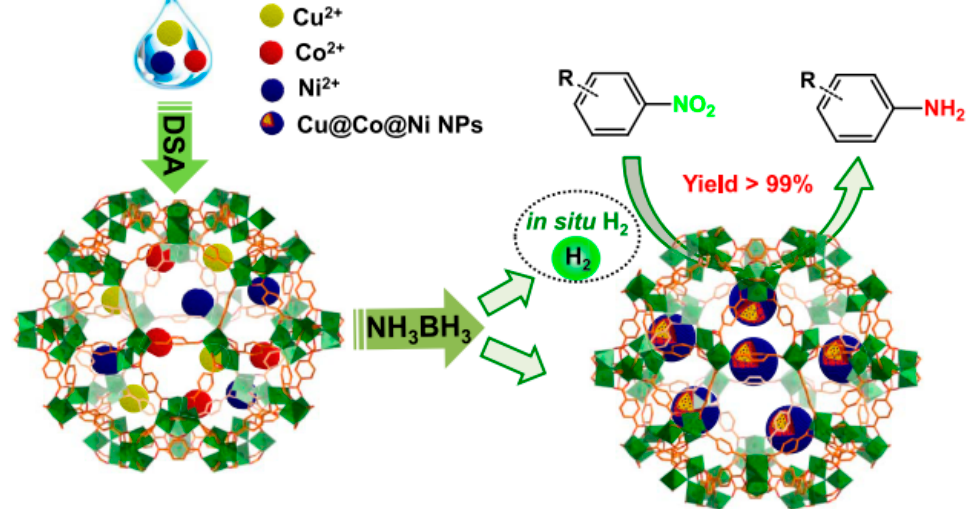
Figure 16. Preparation procedure for Cu@Co@Ni / MIL-101(Cr) and its use as catalyst for a cascade reaction involving the dehydrogenation of NH 3 BH 3 and subsequent hydrogenation of nitroarenes. Reproduced with permission from [65].